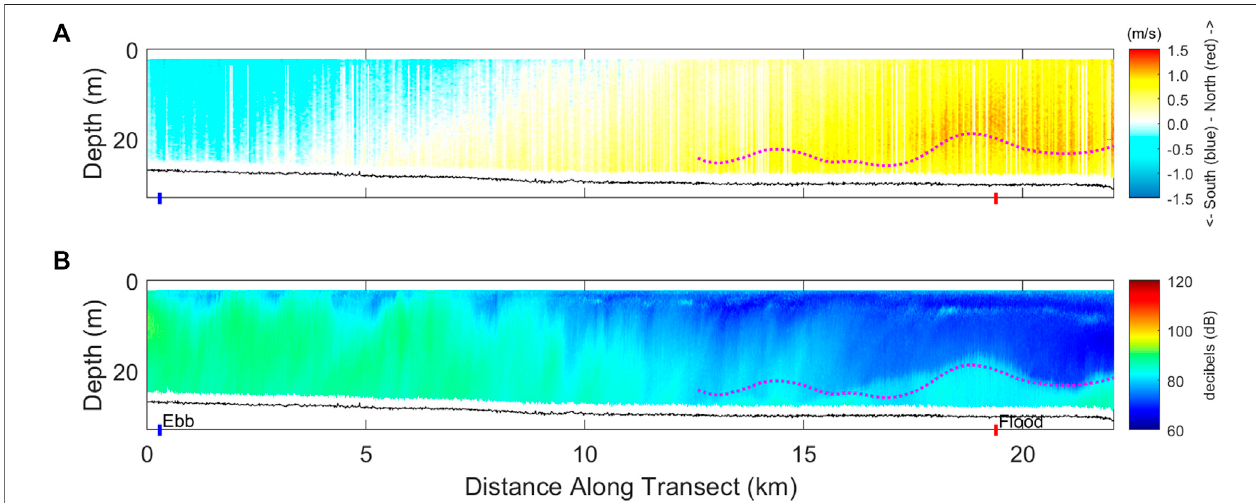
FIGURE 5 | Data observed along Transect #5. The distance traveled along the transect is shown on the horizontal axis, and water depth along the vertical axes. Depth inthewatercolumnwasestimatedafteraccountingfortheapproximatesubmergeddepthoftheADCPsensor.Theblacklinerepresents approximatelocationof the sea fl oor. (A) :water speed (m/s) in direction ofprimary axis,which was9.4 o clockwise from North. Bluecolorsindicate southward fl ow; red indicates northward fl ow. (B) : backscatter intensity (a measure of the return energy in decibels [dB]). The data was fi ltered using the Winriver II software and then a triangular smoothing fi lter was applied. The white vertical bars in (A) represent data that was removed because either the GPS or bottom tracking was deemed unreliable. The blue and red tick marksonthe x -axisrepresentthepositionalongthetransectofebband fl ood,respectively,shownin Figure8 .Thedottedlinesduring fl oodtide(~12 – 25 km)represent the approximate thickness of the near-bed turbid layer, as described in Section 4.1